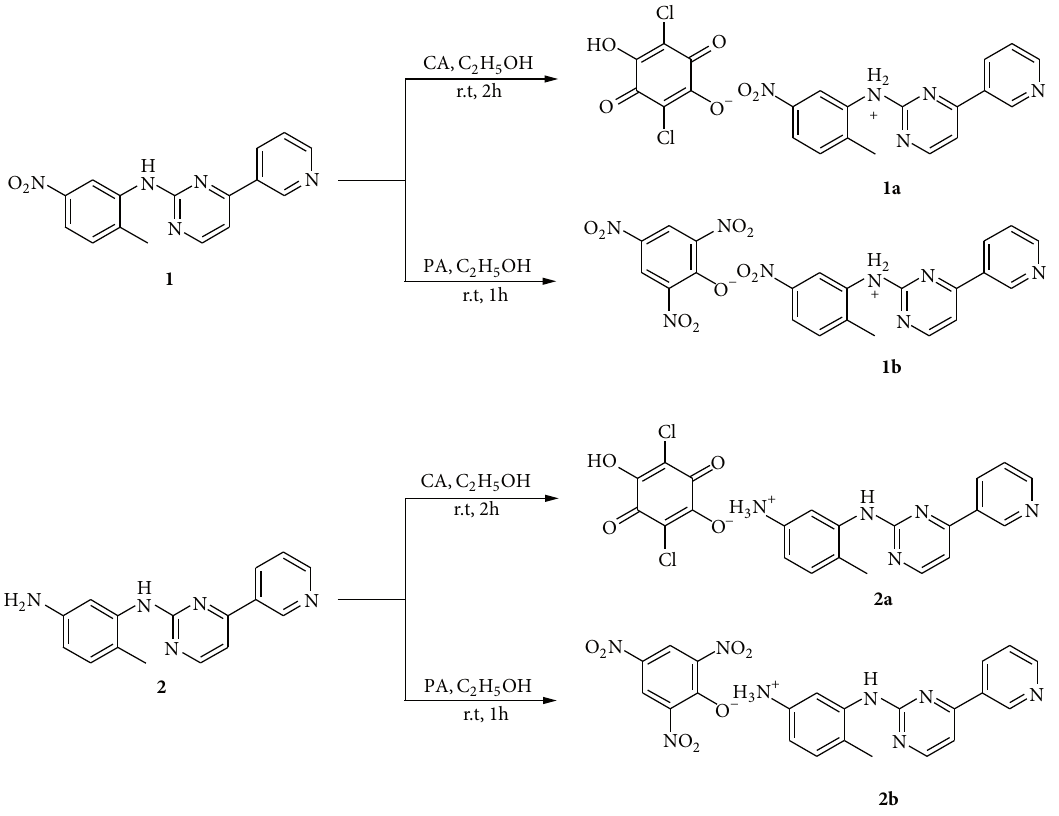
S 1: e illustration of the synthesis of 1a-b and 2a-b.